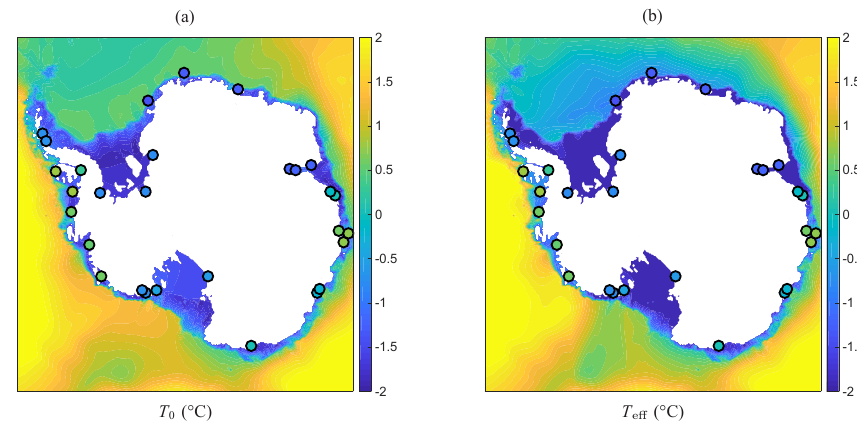
Figure 7. (a) Depth-averaged and interpolated ocean temperature, T 0 , calculated from annual mean WOA13 data. (b) Effective ocean temperature T eff = max { T 0 + (cid:49)T , − 1.9 } constructed from T 0 as described in Sect. 3.2. The circles indicate the positions of the sample points in which the values of (cid:49)T are imposed. The colour of each circle corresponds to the imposed value of (cid:49)T (same colour scale), ranging from − 1.4 to 0.8 ◦ C. The full (cid:49)T field is obtained by linearly interpolating these values.